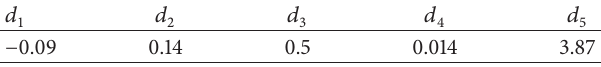
Table 1: Parameters for Johnson-Cook damage initiation model.